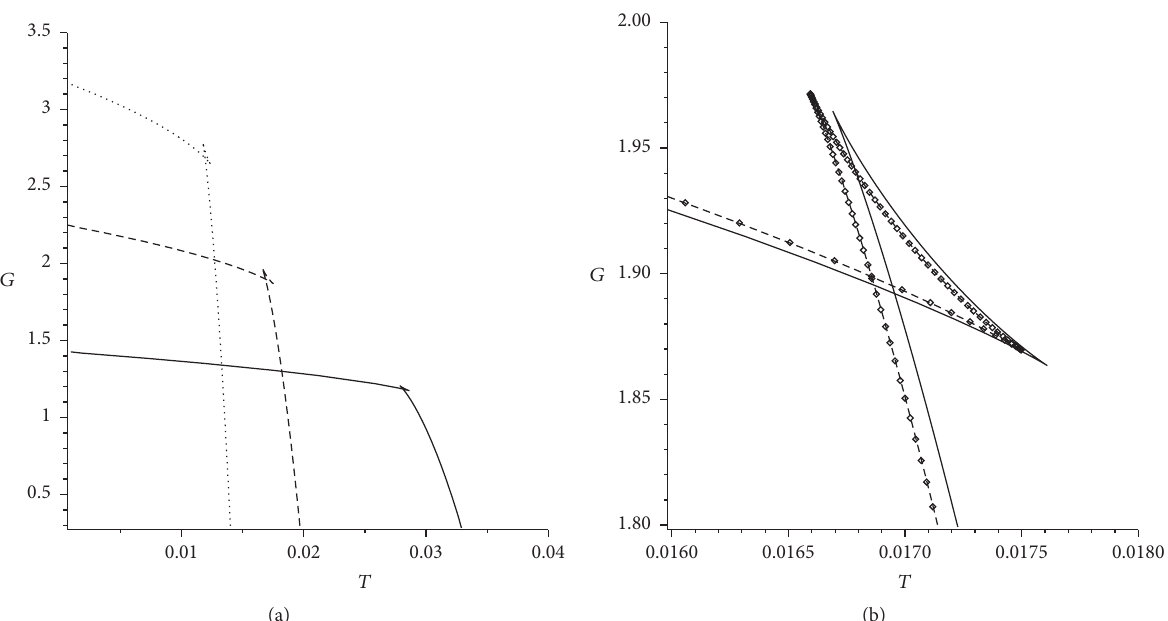
Figure 3: Isobaric plots that reflect the effects of YM charge (a) and BI parameter (b). On (a), the parameters of all the isobars are taken as = 1 , 𝛽 = 10 , and 𝑃 = 0.7𝑃 𝑄 𝑒 parameters of all the isobars are taken as 𝑄 𝑒 = 1 , 𝑄